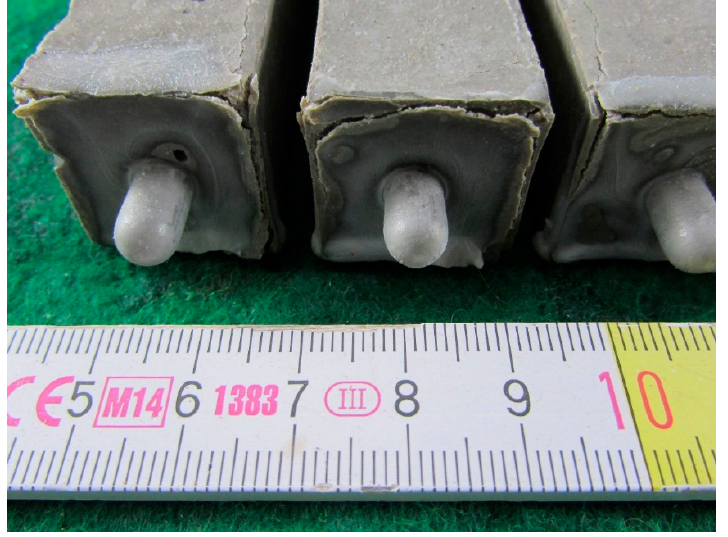
Figure 17. View of the front faces of the test specimens from M3 after 285 days in the sulfate bath— the front face surfaces tend to separate from the specimen cores.